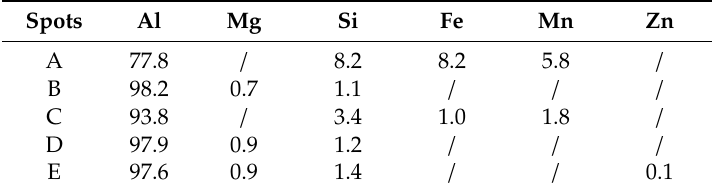
Table 2. Energy dispersive spectrometer (EDS) results of alloy AA and AZ after solution treatment (at %).